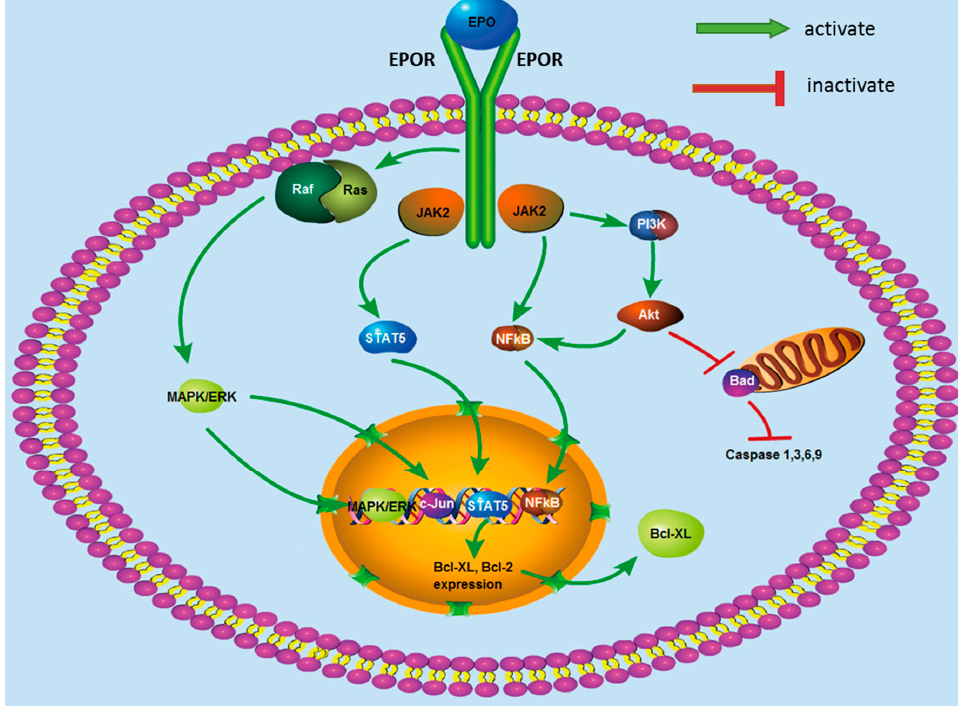
Figure 1. EPO-induced intracellular signaling pathways Erythropoietin and its receptor signaling through JAK2 activate multiple downstream signaling molecules including STAT5,